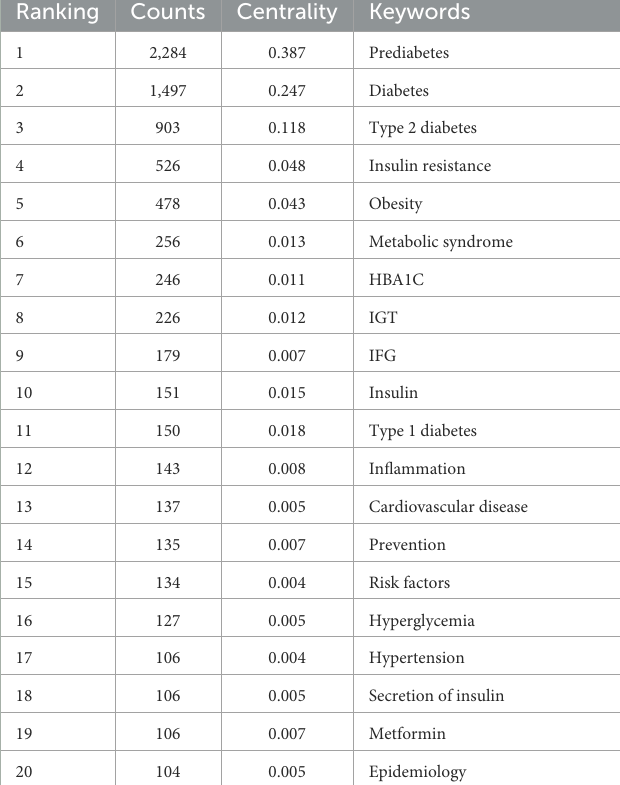
TABLE 1 Top 20 keywords of